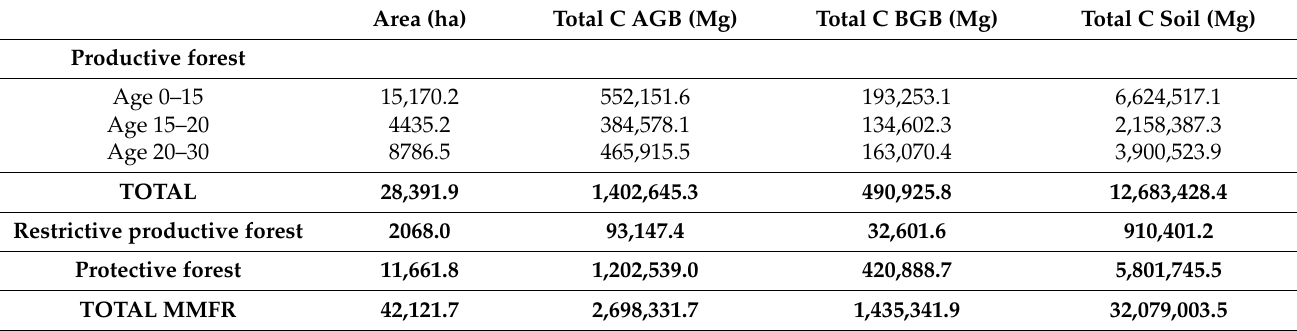
Table 2. Total carbon stock (C) in AGB, BGB, and top 1 m of soil for the productive, restrictive productive, and protective forest zones in the MMFR. For the protective forest the biomass and carbon per ha was considered at least equal to a 30-year-old stand, as these forest areas are in many cases older than that; hence, the values reported for the protective forest are an underestimation of the real carbon